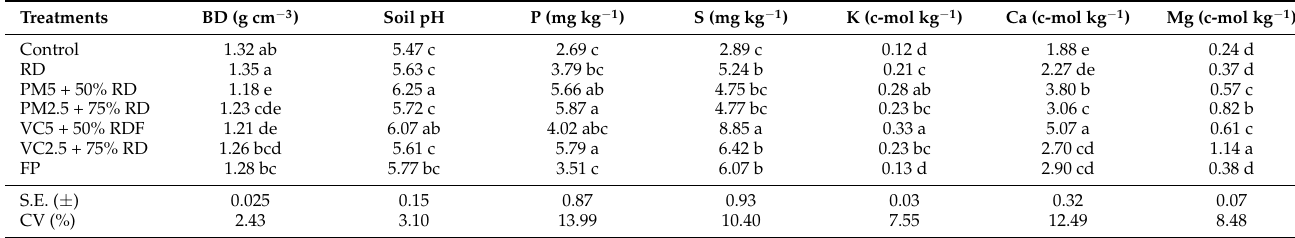
Table 4. Soil physical and chemical properties after rice